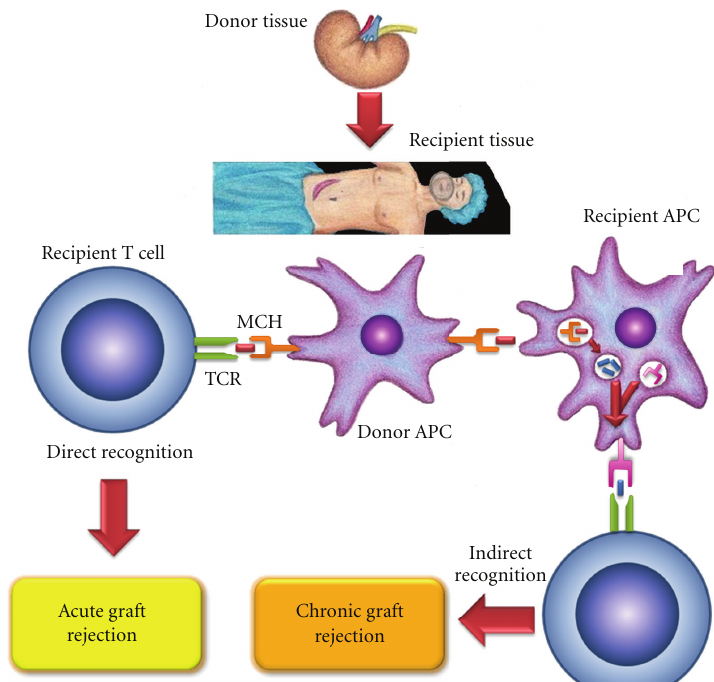
Figure 2: Allogeneic immune response: this could happen by three recognizing mechanisms: first, an indirect recognition: this type of mechanism has a dominant role in chronic rejection; second, a direct recognition: this mechanism determines a strong immune response in the acute rejection; third mechanism, a “semi-direct” recognition that could be mediated by immunoglobulin-like receptors of natural killer (NK) cells and can mediate potent acute